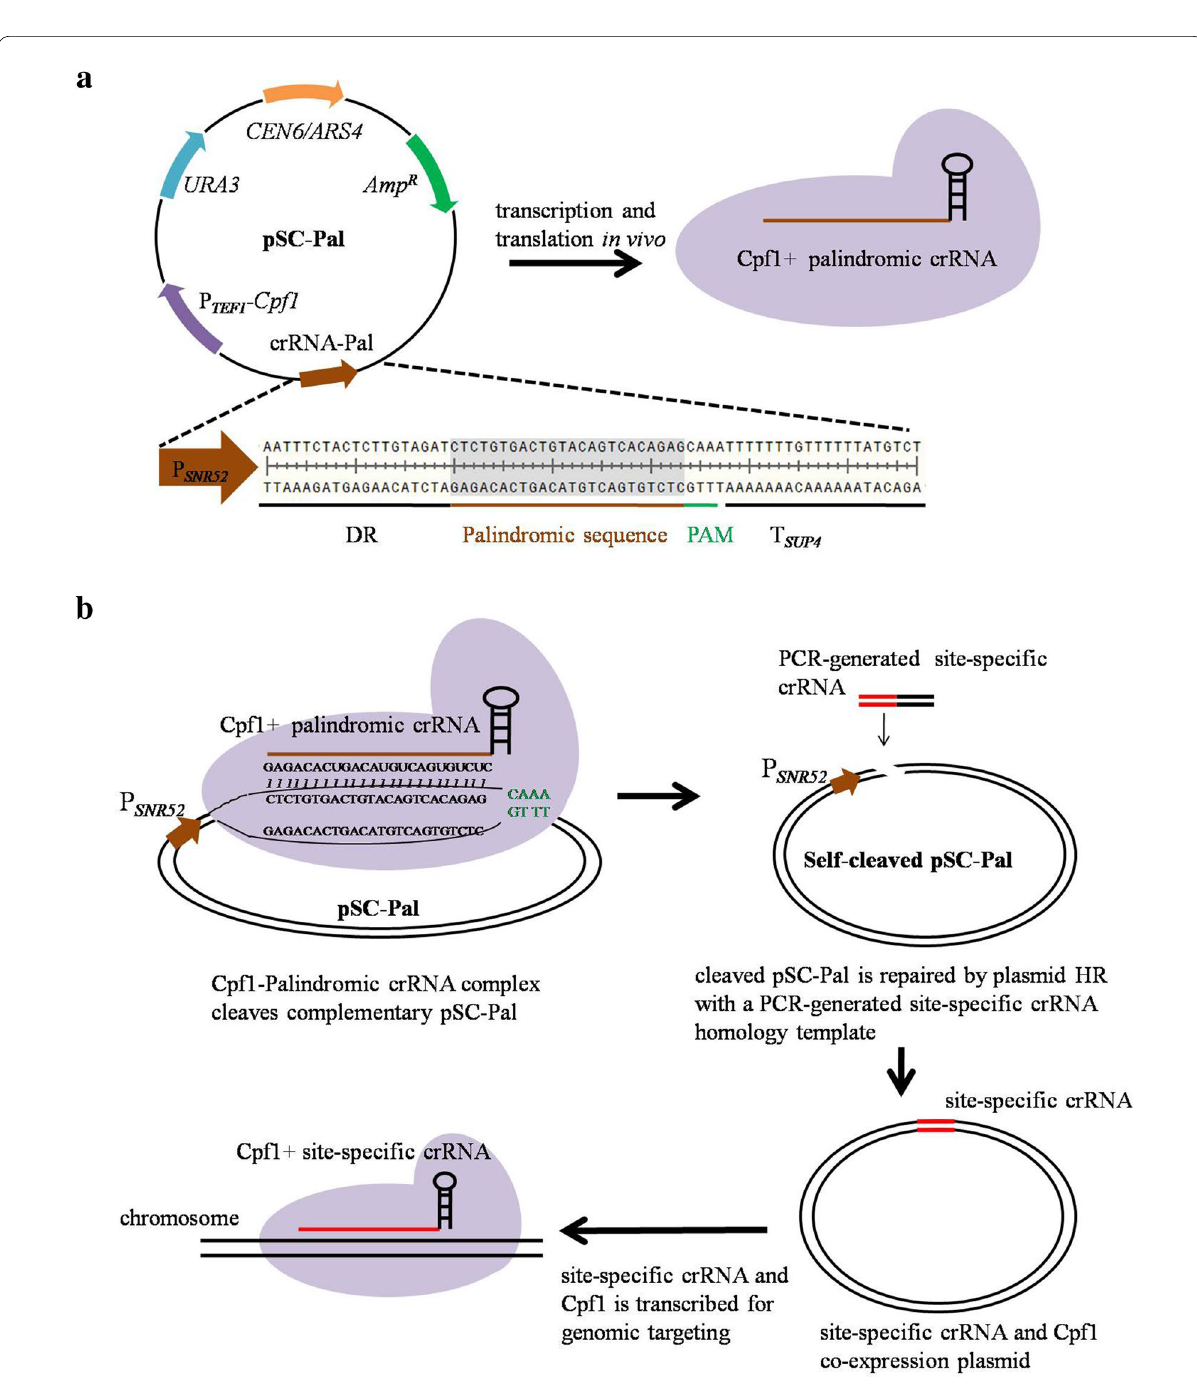
Fig. 1 Schematic of scCRISPR/Cpf1. a pSC‑Pal: the self‑cleaving complementary palindromic crRNA and Cpf1 co‑expression plasmid. b Schematic shows the scCRISPR/Cpf1 process that occurs inside target yeast cells. CEN6/ARS4 , replication origin; URA3 , selection marker used in yeast; Amp R , selection marker used in E. coli ; P TEF1 ‑ Cpf1 , the Cpf1 expression cassette driven by promoter P TEF1 ; DR, 19 bp direct repeat which shown in black; PAM, protospacer‑associated motif sequence; P SNR52 , SNR52 promoter; T SUP4 , SUP4 terminator; the complementary palindromic sequence of crRNA was shown in brown and the site‑specific sequence of crRNA was shown in